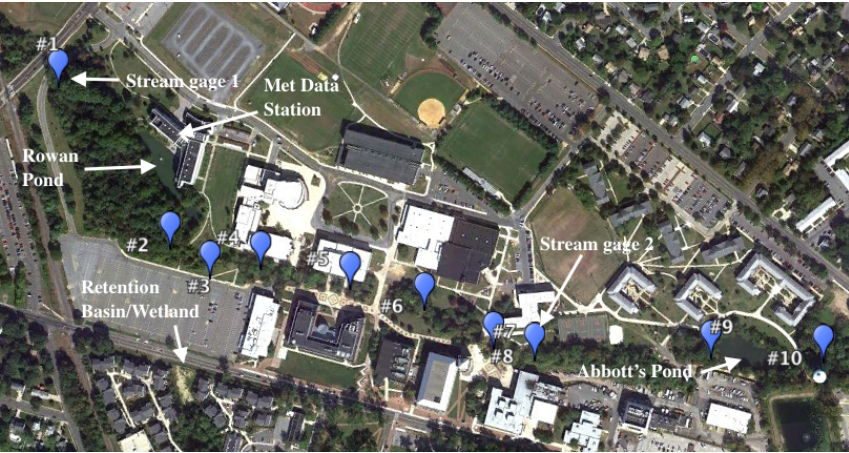
Figure 2. Location of sites where stream temperature data were